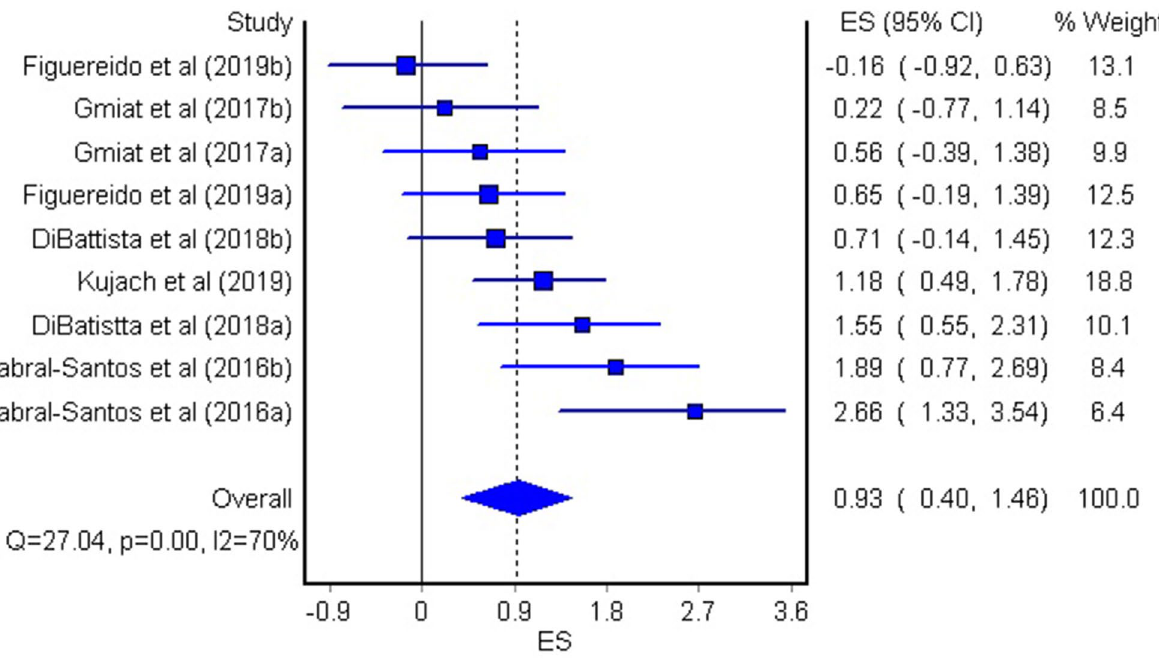
Figure 4. The effect of chronic interval training (IT) on circulating BDNF concentration. The lines indicate 95% confidence intervals (CI), and the square reflects the standardized differences (SMD) for each study. The diamond in the forest plot indicates the overall effect size